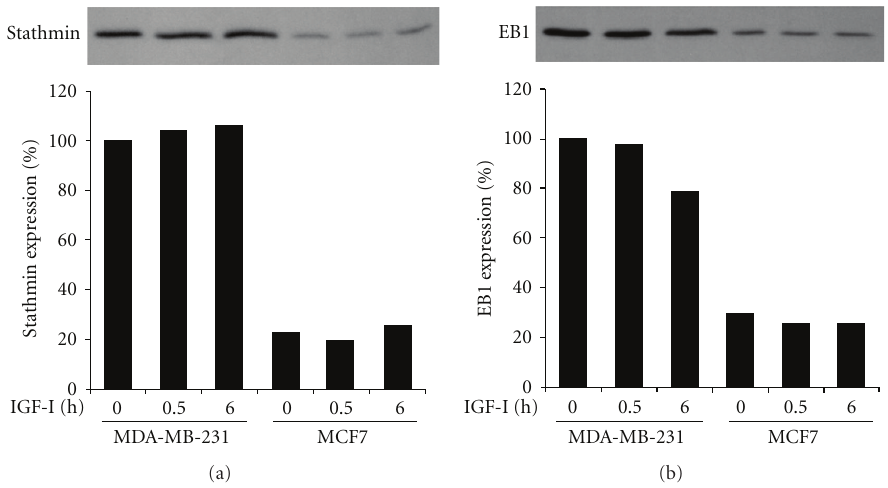
Figure 5: Overexpression of stathmin and EB1 in MDA-MB-231 cells compared to MCF7 cells. Cells after stimulation with IGF-I for 0, 0.5, or 6h were lysed and processed for immunoblotting with antibodies to stathmin (a) and EB1 (b). Band intensity was measured, and values are given as expression relative to that in unstimulated control MDA-MB-231 cells.